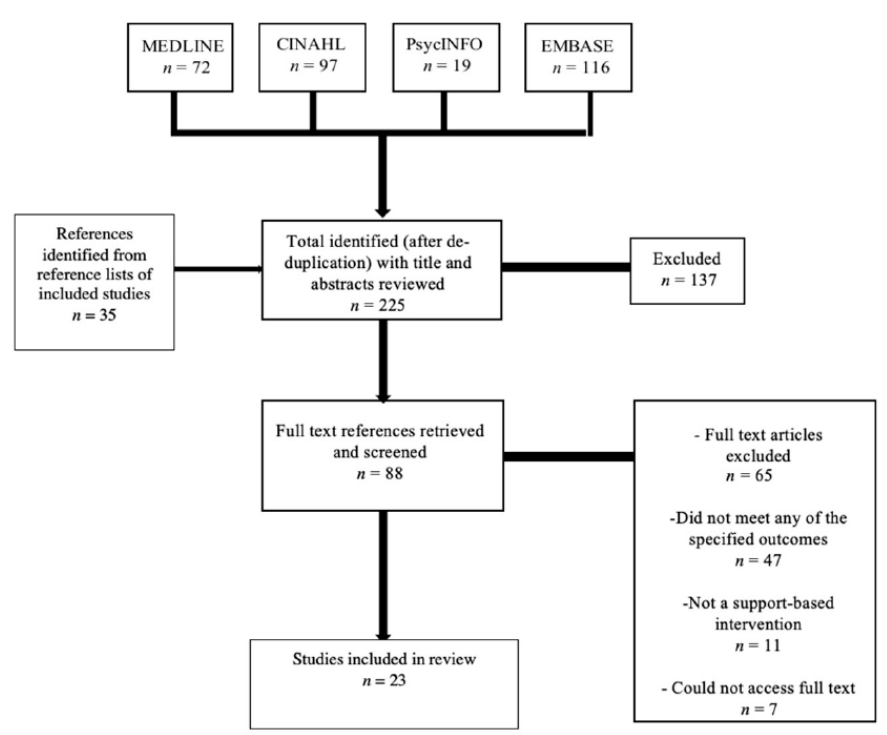
Figure 1. PRISMA flow chart of included